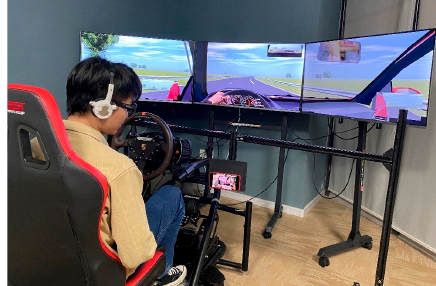
Figure 2. Driving simulator and